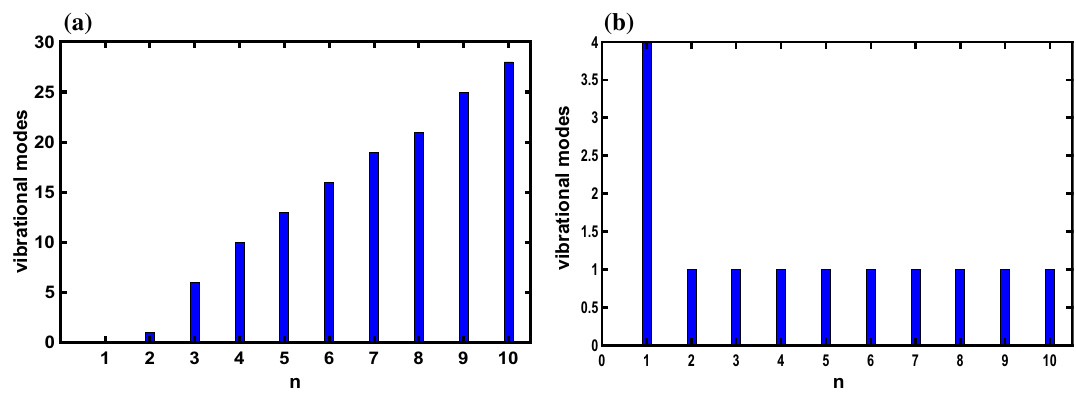
Fig. 5 Number of vibrational states for a kink-antikink and b antikink-kink, corresponding to the Schrödinger potentials of Figs 4a-b